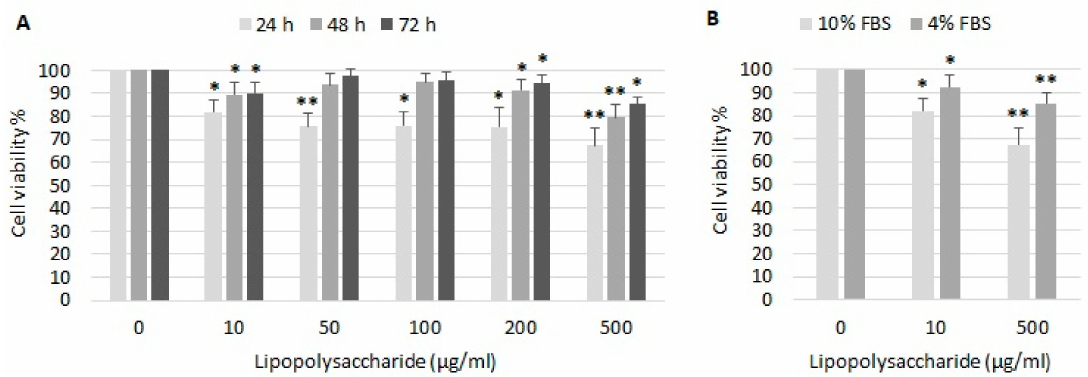
Figure 1. The e ff ect of lipopolysaccharide (LSP) on the relative viability of A549 cells. A549 cells were treated with various concentrations of LPS ( A ) for 24, 48 and 72 h in the presence of 10% FBS, and ( B ) for 24 h in the presence of 10% or 4% FBS, respectively. The relative cell viability was determined by the MTT test as described in Material and Methods. The control value (100%) was determined in cells which were incubated without LPS. Data are presented as means ± SDs from three independent experiments. * p < 0.05, ** p < 0.01. FBS—fetal bovine